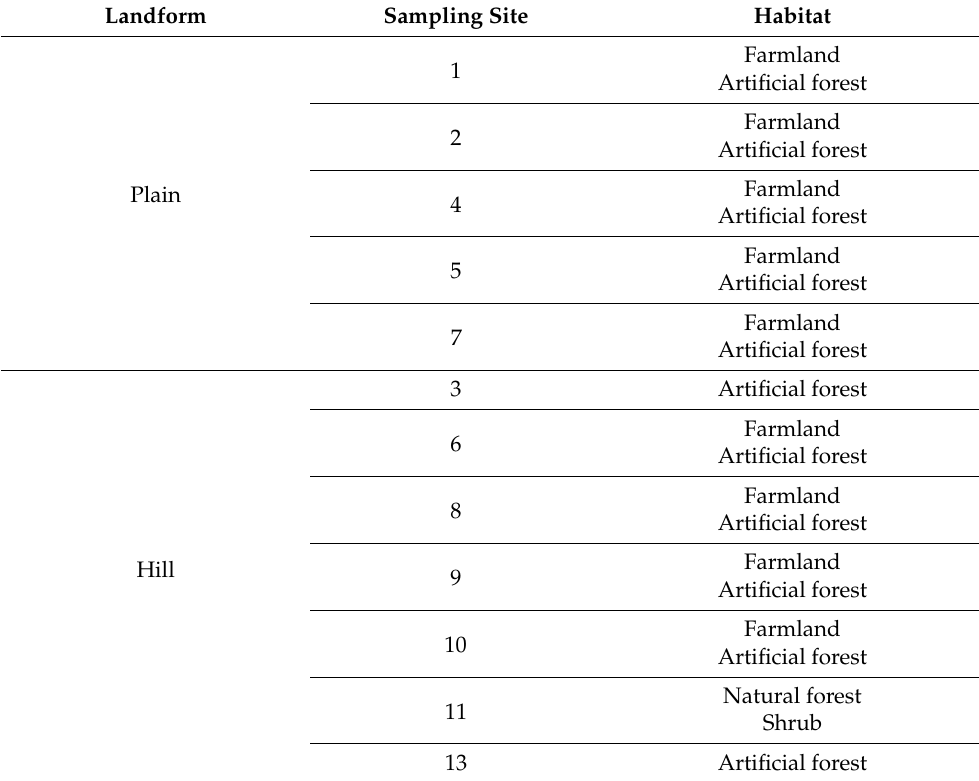
Table A1. The type of habitat contained in each sampling site.